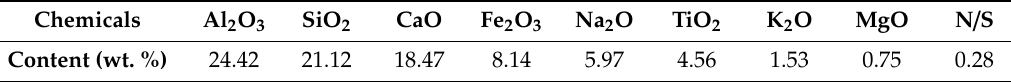
Table 1. Main chemical composition of Bayer red mud measured by X-ray fluorescence. Chemicals Al 2 O 3 Content (wt. %)